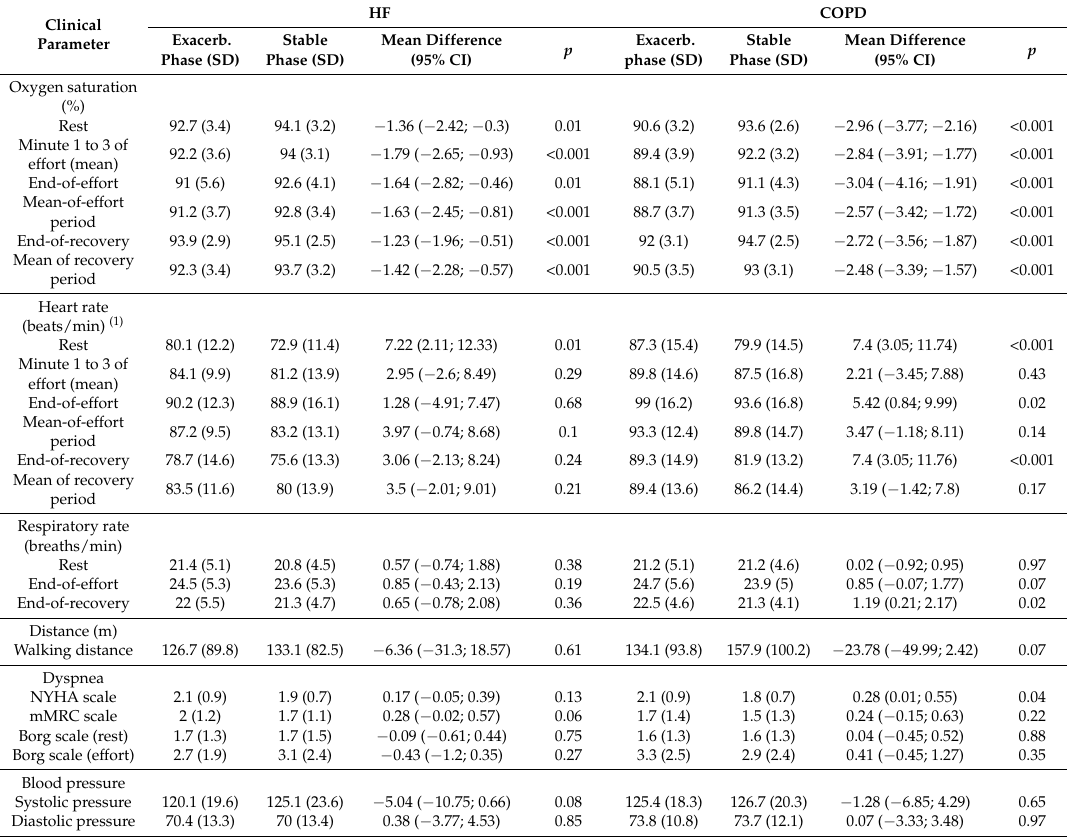
Table 2. Physiological parameters according to disease and exacerbation/stable